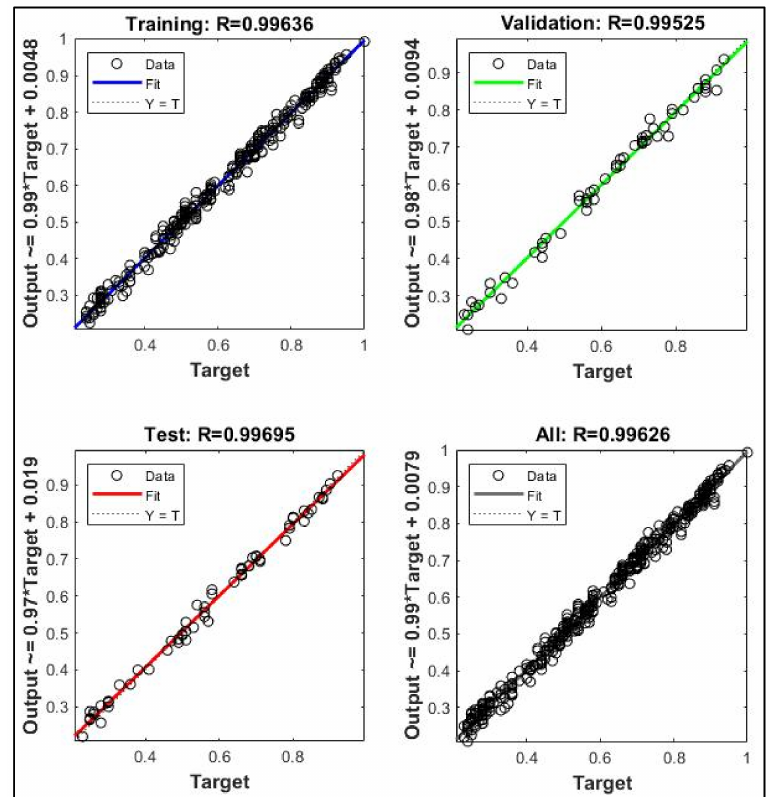
Figure 8. Regression plots of Model